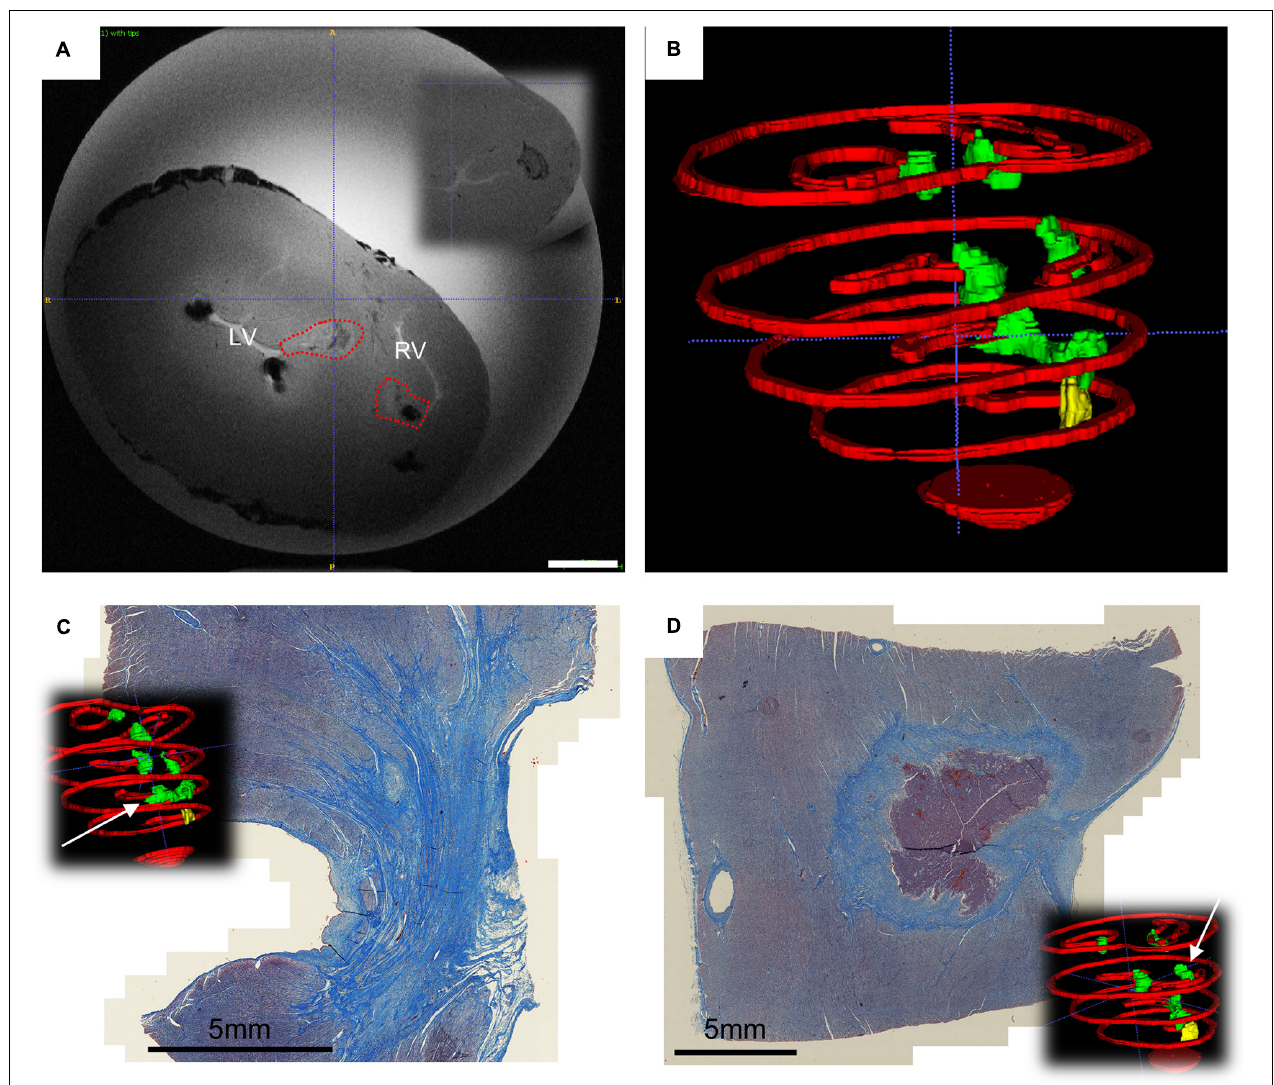
FIGURE 5 | Ventricular findings at the end of follow-up. (A) Ex vivo T1 axial scans with highlighted changes identified with AC pulsed field ablation lesions (red dotted lines) – in the inset it is visible a control RF ablation lesion. Scale bar is 10 mm; (B) Posterior view of the 3D rendering of ventricular myocardial perimeter (red), AC pulsed field ablation lesions (green) and RF ablation lesions (yellow); (C) trichrome staining of apical transmural lesions across the interventricular septum; (D) trichrome staining of basal isolated AC pulsed electric field ablation lesion, with intact core of